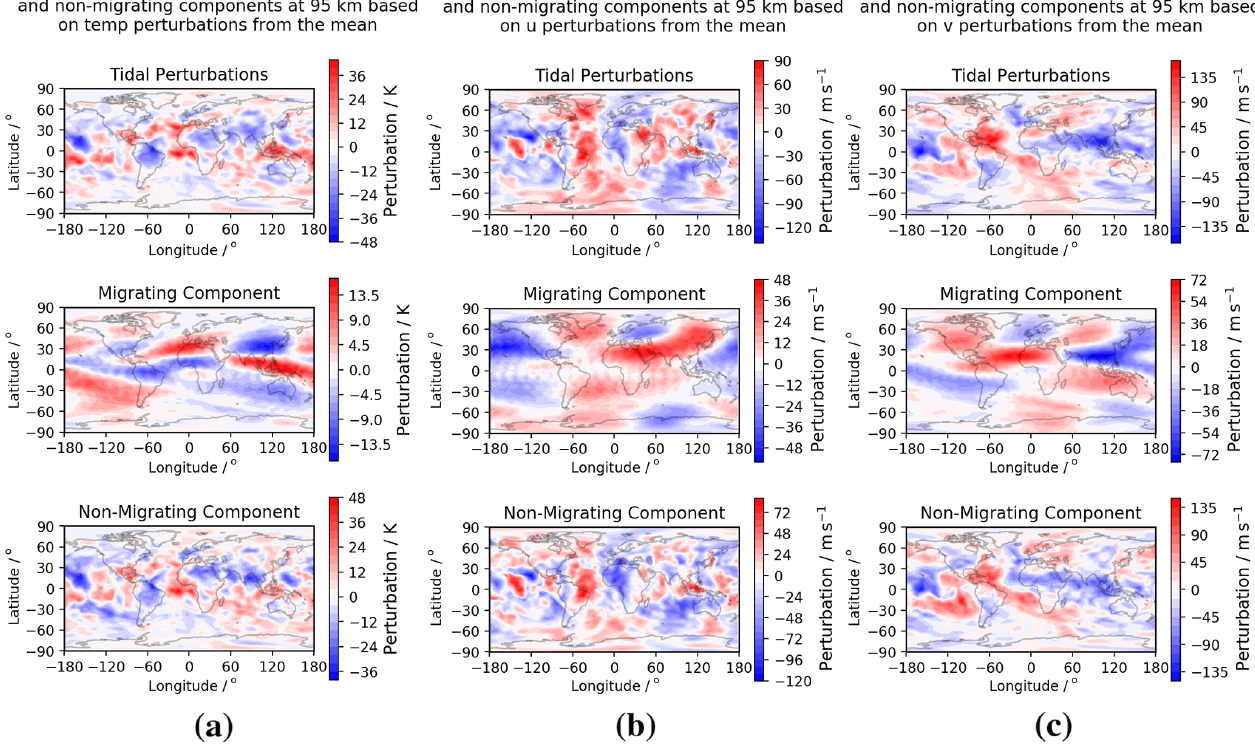
Figure 7. Longitude–latitude snapshot at 00:00UT on the first day of January of tidal perturbations at 95km for (a) temperature, (b) zonal ( u ) winds, and (c) meridional ( v ) winds. The equatorial DW1 tide and polar SW2 tide can be seen as the primary components of the migrating tide, with a superposition of several zonal wavenumbers apparent in the non-migrating